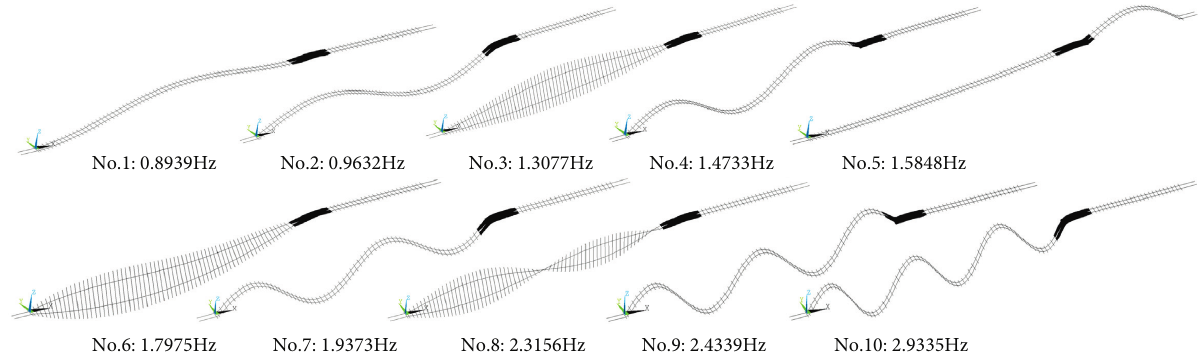
Figure 2: The first ten vibration modes of the stress ribbon